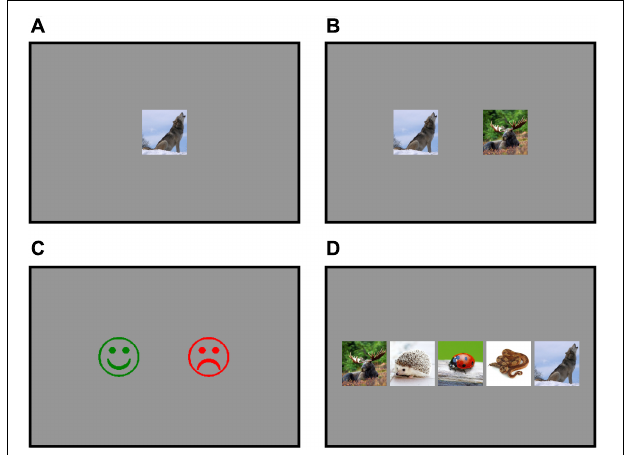
FIGURE 1 | Examples of what the children were shown during learning tasks and tests. (A) During the intentional task with production, the intentional task without production, and the incidental task, the children heard an English word for an animal and a picture of the same animal was displayed on the screen. (B) During the cross-situational statistical task, the children were presented with pictures of two different animals: one that corresponded to the word they heard and another one that did not. (C) During the word-form test, the children responded by pressing an image of a smiling face and a sad face. (D) During the word meaning test, the children were presented with pictures of five different animals from the learning tasks, one of which corresponded to the word they